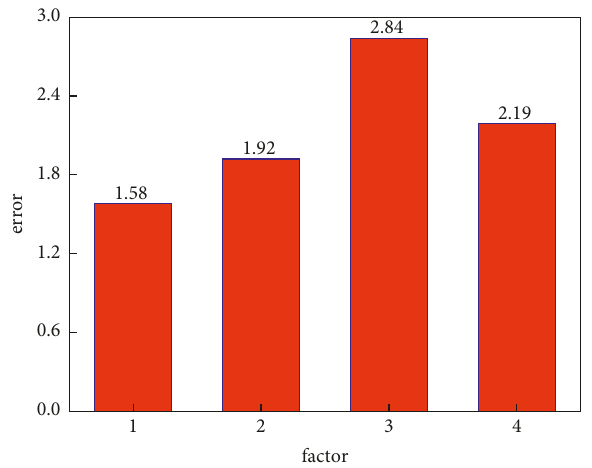
Figure 8: The average prediction error of four features of